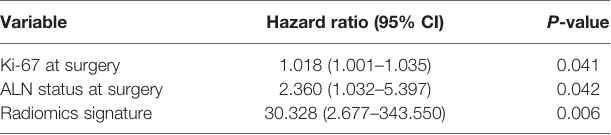
TABLE 1 | Univariate cox analysis of disease-free survival in the training cohort. TABLE 2 | Multivariate cox regression analysis for DFS in